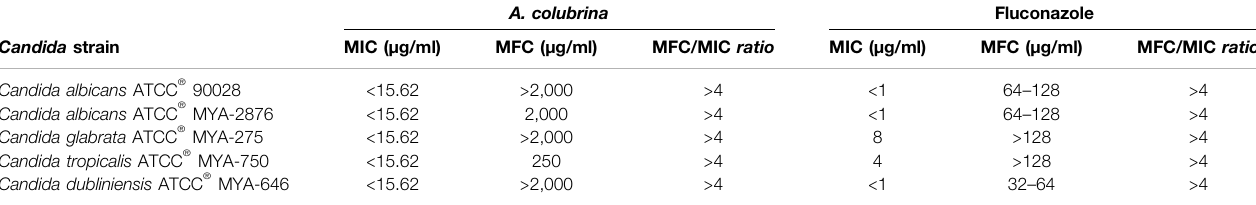
TABLE 2 | Minimum Inhibitory Concentration (MIC) and Minimum Fungicidal Concentration (MFC) of A. colubrina extract against Candida